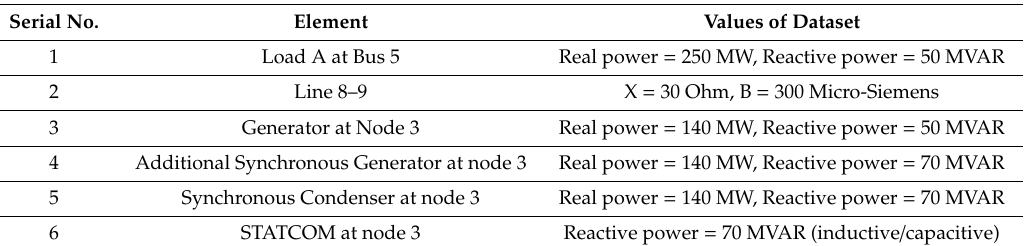
Table 3. Definition of Input.